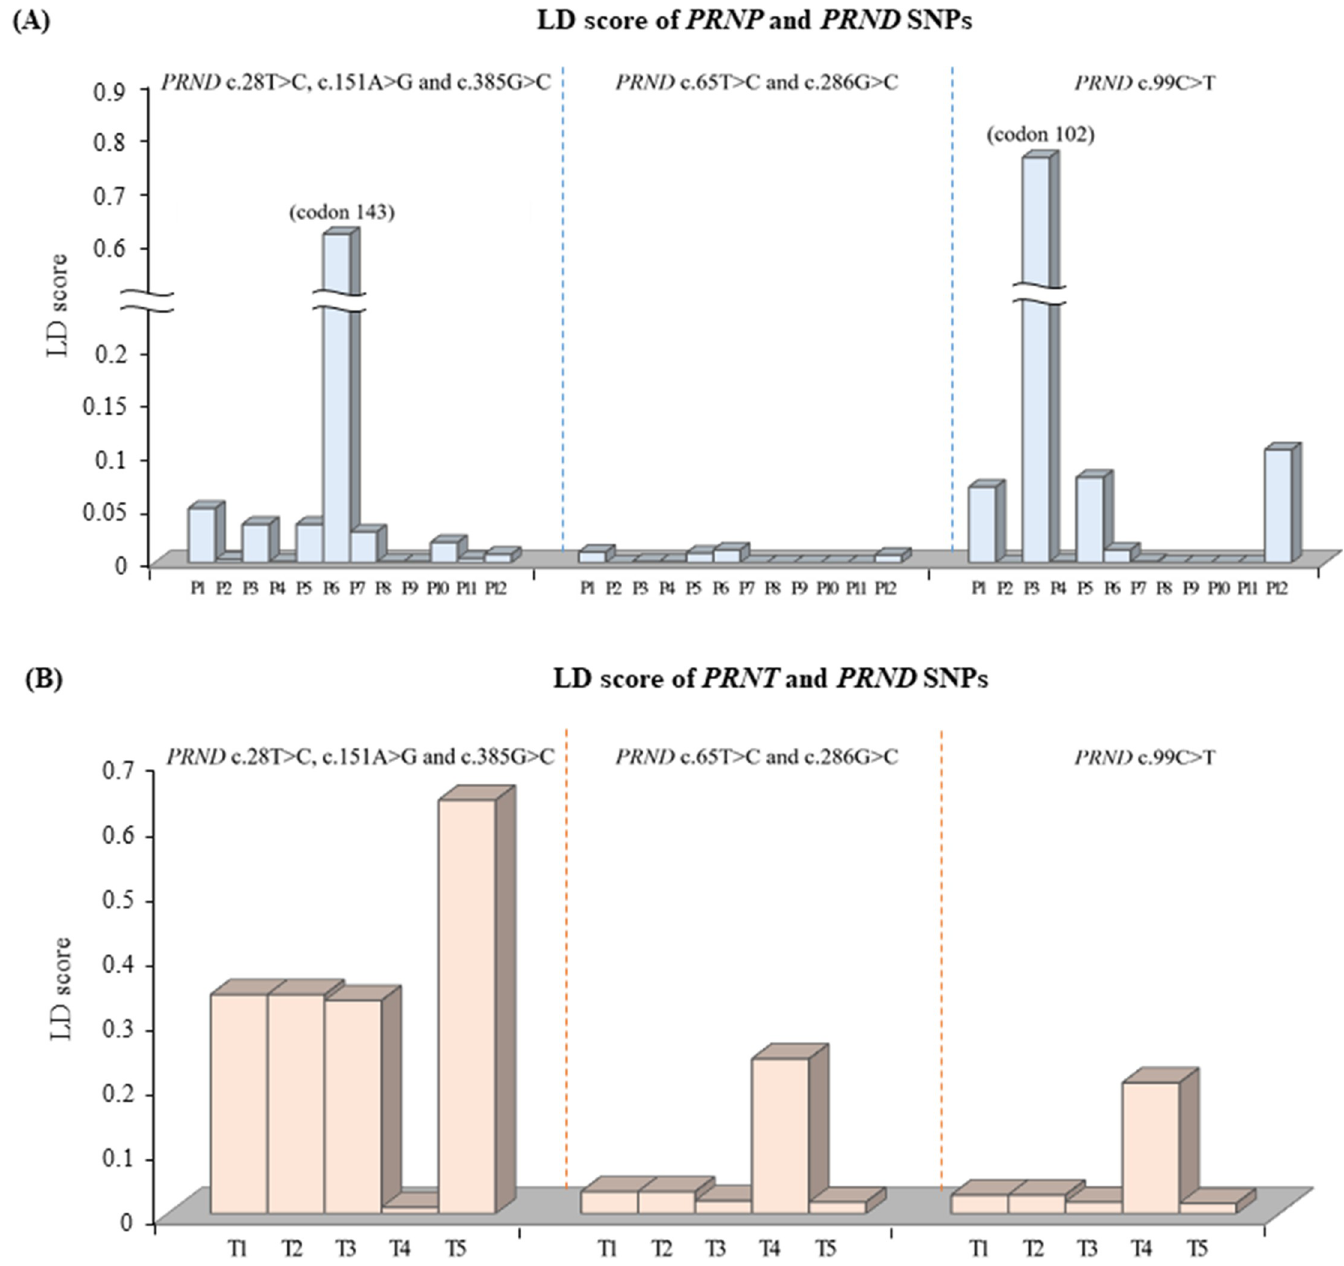
Fig 2. The linkage disequilibrium (LD) scores between single nucleotide polymorphisms (SNPs) of the PRND gene and those of the PRNP and PRND genes. (A) The LD scores between PRND and PRNP SNPs. P1 ~ P12 indicate PRNP SNPs as follows: P1, c.126G > A (codon 42); P2, c.302A > G (codon 101); P3, c.304T > G (codon 102); P4, c.379G > A (codon 127); P5, c.414T > C (codon 138); P6, c.428A > G (codon 143); P7, c.437A > G (codon 146); P8, c.461G > A (codon 154); P9, c.512A > G (codon 171); P10, c.632G > A (codon 211); P11, c.652A > C (codon 218); P12, c.718C > T (codon 240). (B) The LD scores between PRND and PRNT SNPs. T1 ~ T5 indicate PRNT SNPs as follows: T1, c.-114G > T; T2, c.-58A > G; T3, c.71C > T (codon 24); T4, c.102G > A; T5, c.321T >